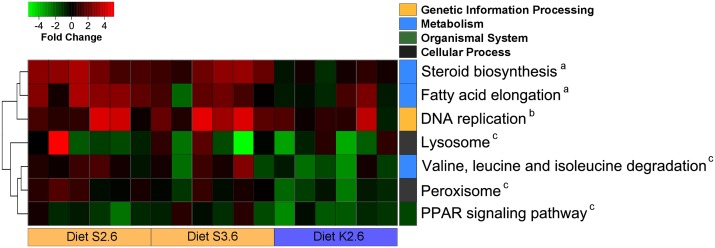
Heatmap plotting GAGE results from the 1d test in the intestine of 2.5 g fry fed diets S2.6, S3.6 and K2.6.Expression values are reported for each individual replicate (n = 6) compared to.fry (2.5g) fed the basal unsupplemented (low phospholipid) diet. Only gene-sets with q < 0.05 are shown. Pathways are colour-coded based on the broad classification category (Kegg). Further details are provided in S2 Table. Gene-sets marked with an “a” are differentially expressed in S2.6 compared to B, “b” in S3.6 vs B and “c” in K2.6 vs B. Data were plotted using heatmap.2 [37] and rows were clustered according to Euclidean distance.